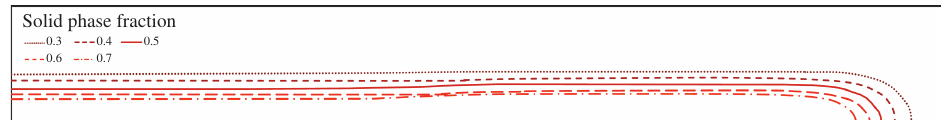
Figure 9: Solidification front position under different solid phase fraction.